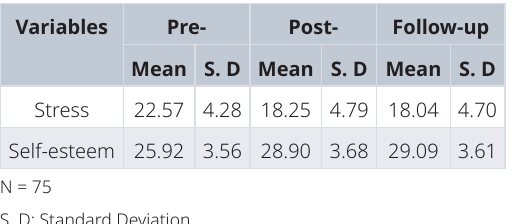
Table 3. Collective measures of stress and self- esteem for the participants during pre-, post-, and follow-up phases.